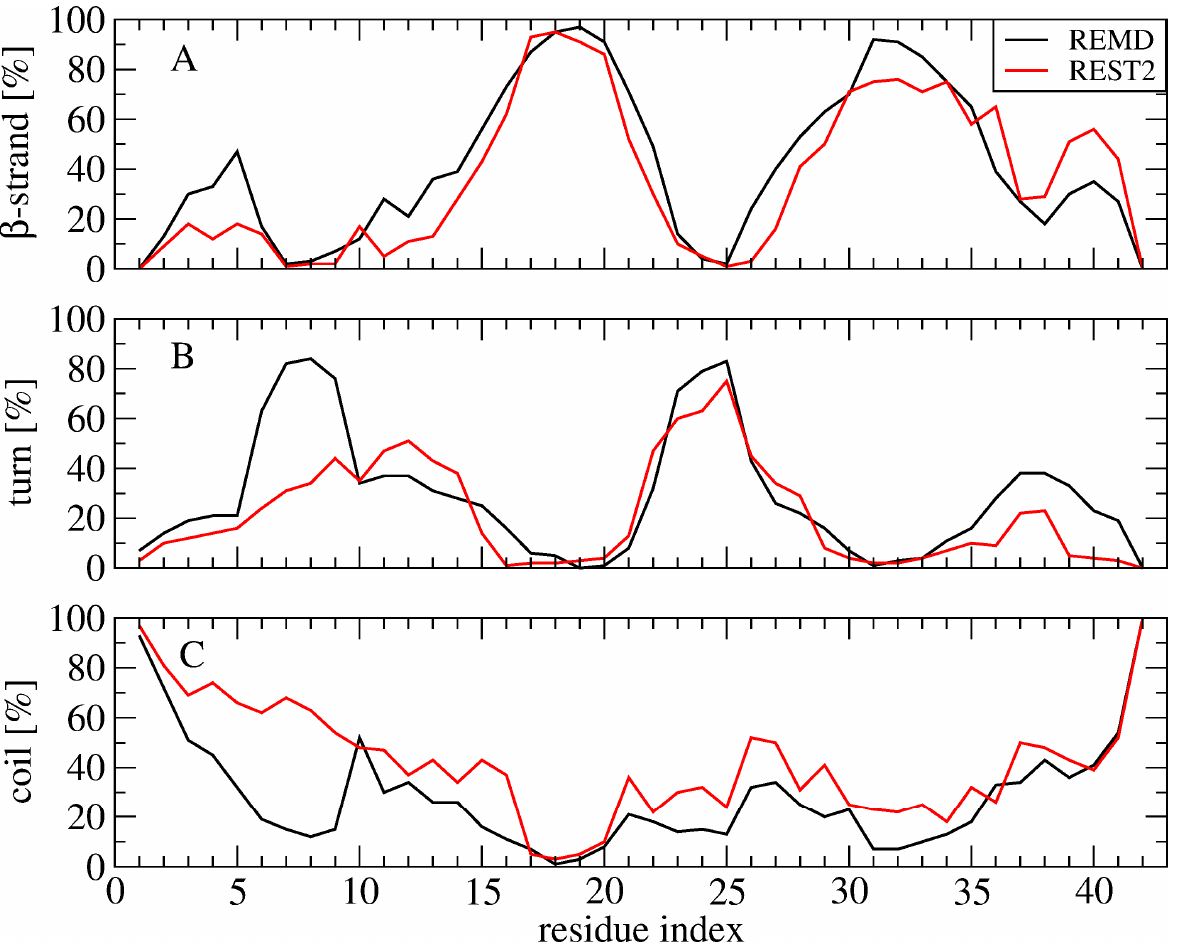
Figure 4. Secondary structure composition along the amino acid sequence using the time interval 50–250 ns of the REMD simulation at 315 K and the time interval 50–250 ns of the REST2 simulation at 310 K. ( A ) beta-strand, ( B ) turn and ( C ) coil content.